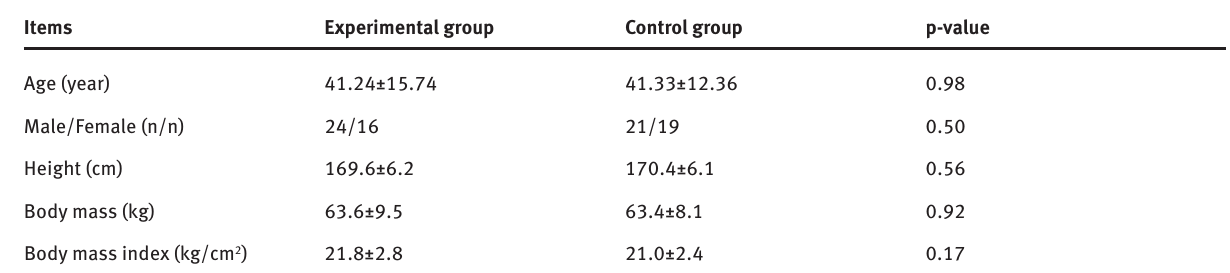
Table 1: Comparison of general data in two